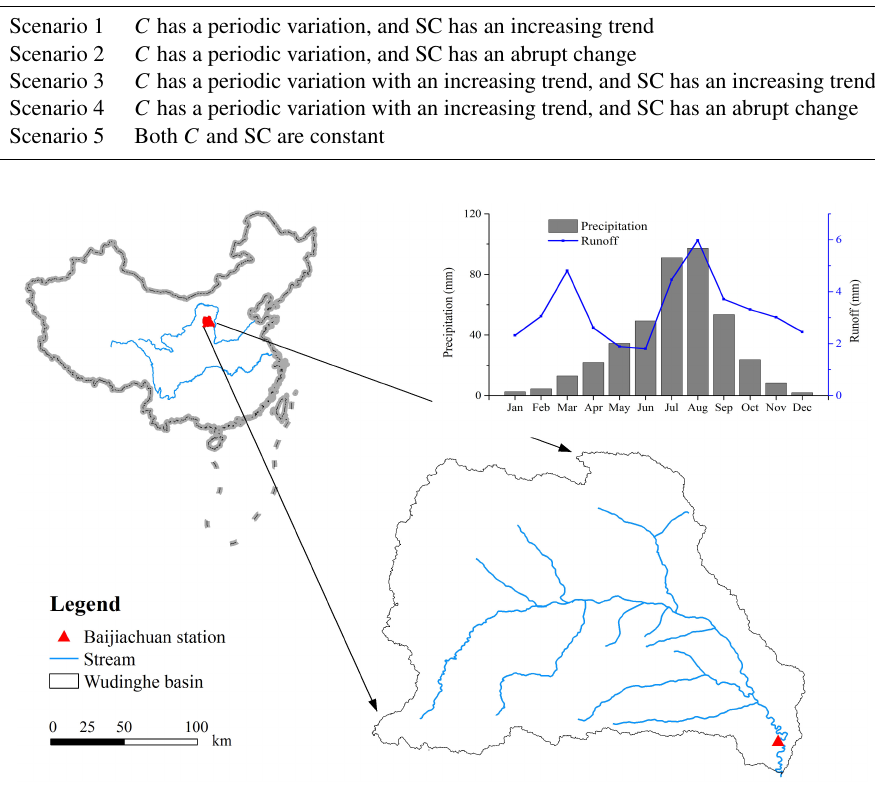
Figure 1. Location and mean monthly precipitation and runoff from 1956 to 2000 of the Wudinghe basin.